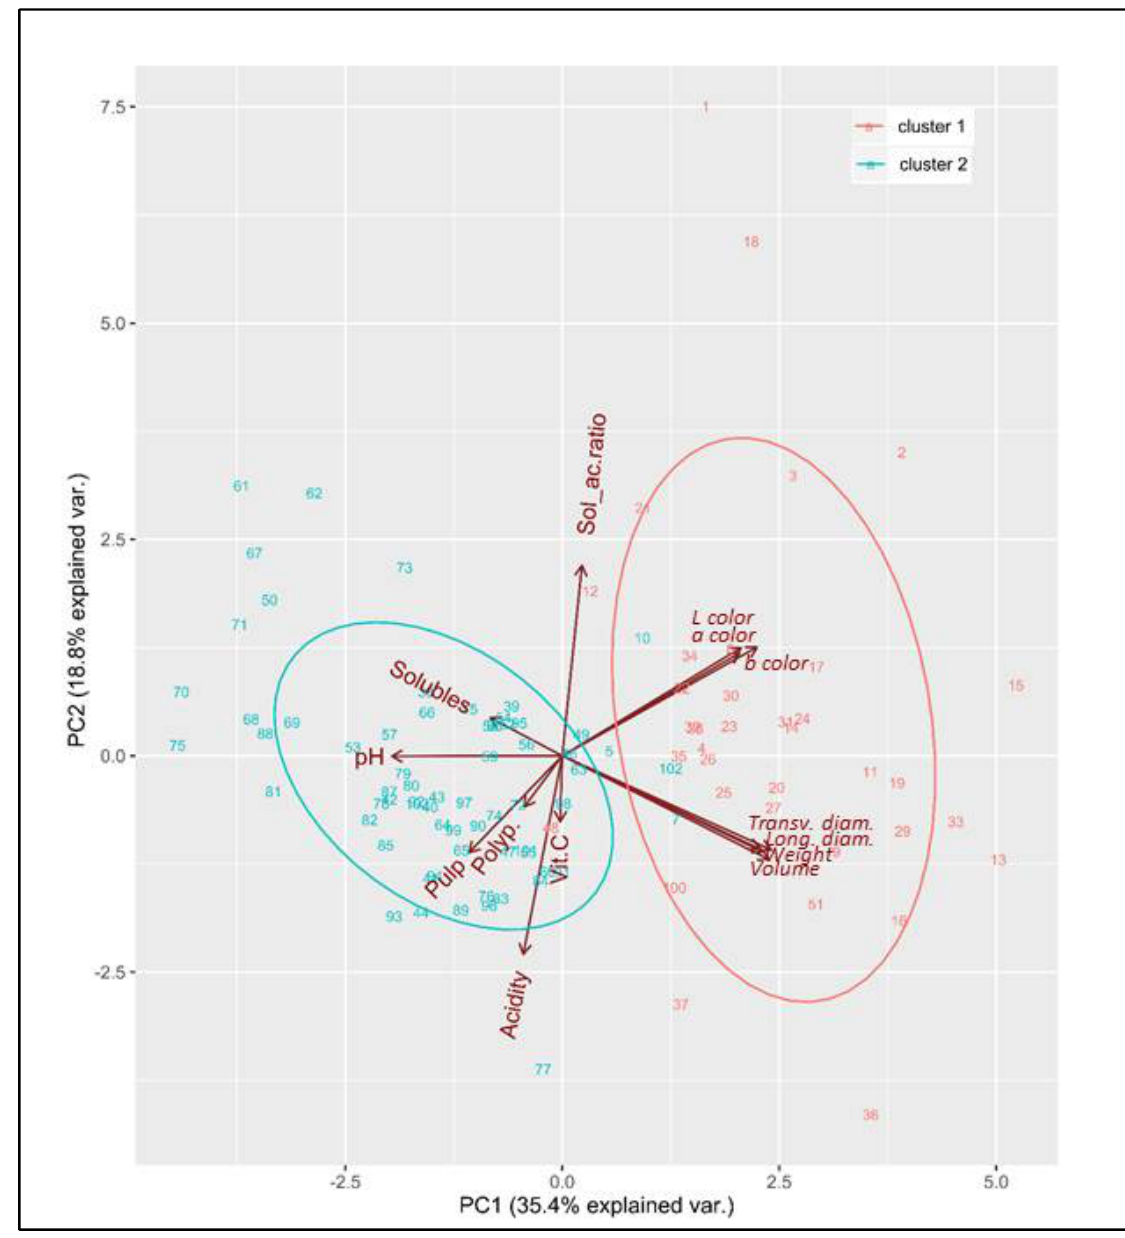
Figure 7. Scatter plot of the scores of acerola samples on the two-dimensional plane defined by PC1 and PC2 as calculated from the complete dataset by PCA. Samples are grouped according to the HCA results (the confidence level of 0.95 defines the ellipses in such manner that approximately 95% of the new observations from that group fall inside the ellipse).